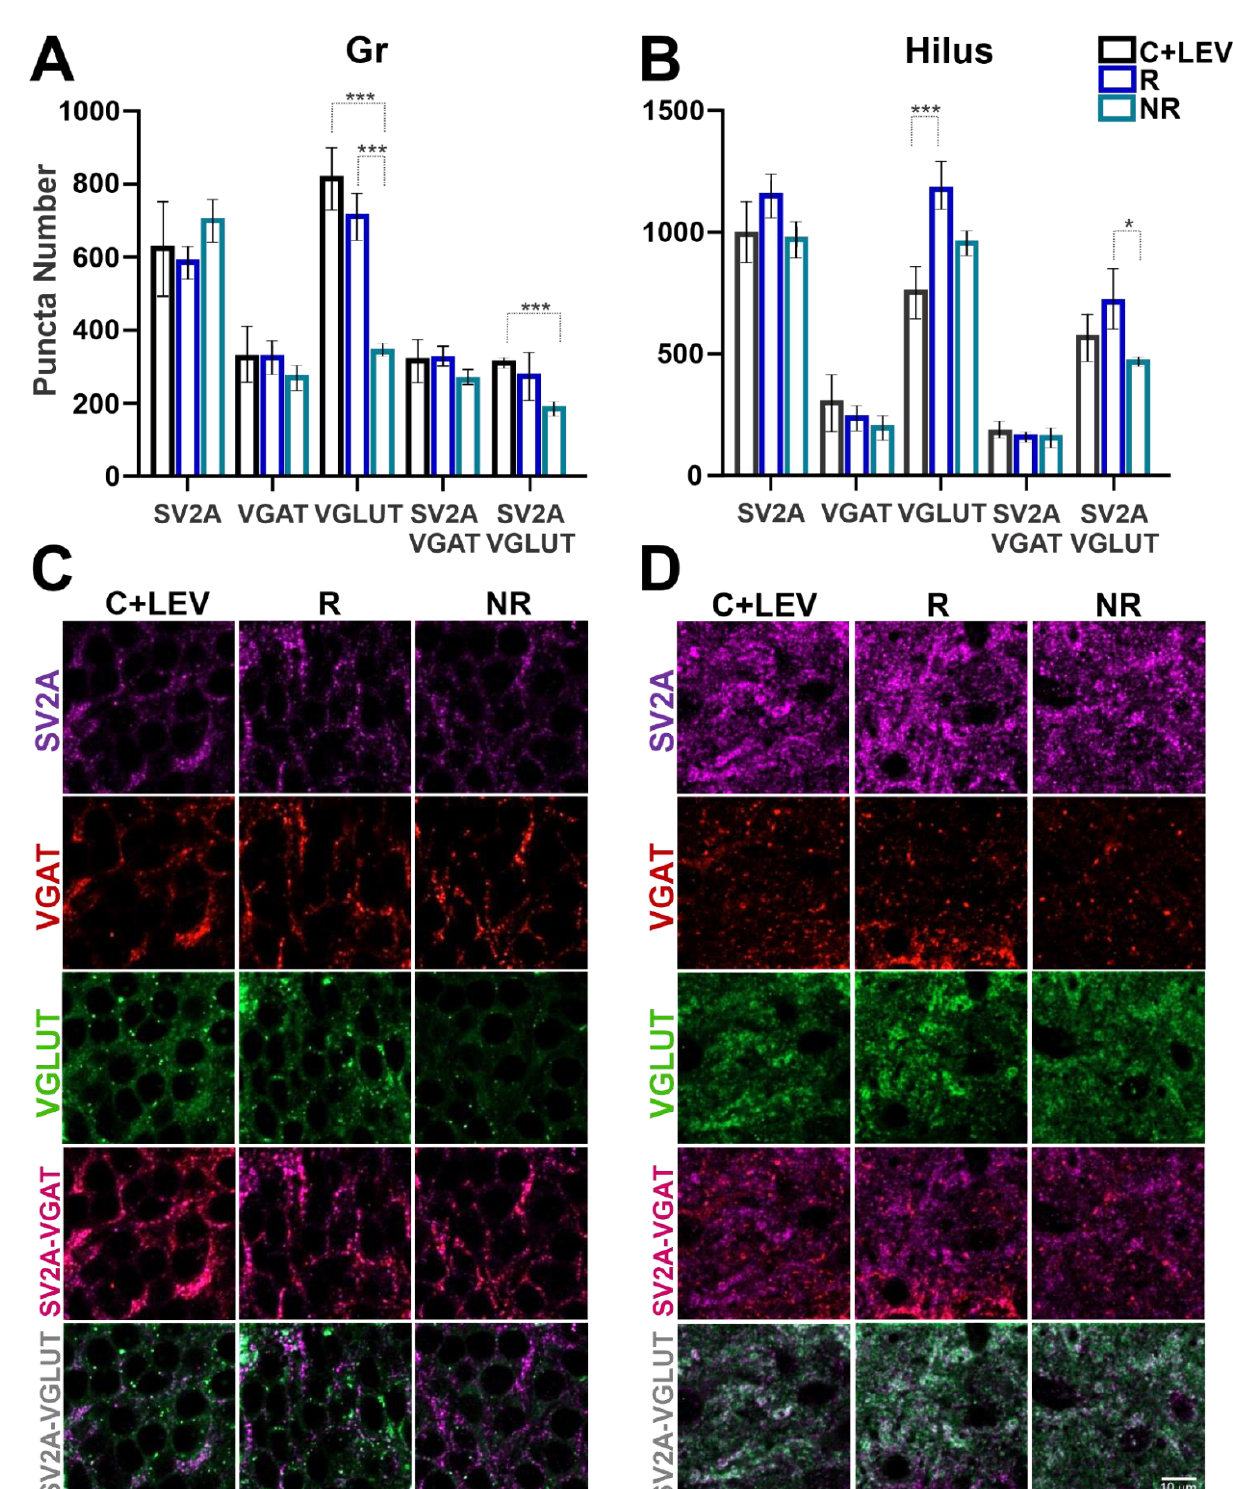
Figure 4. Quantification of SV2A, VGAT, VGLUT, SV2A-VGAT or SV2A-VGLUT puncta in the dentate gyrus granular layer (Gr) and hilus. ( A , B ) Graphs showing protein puncta (mean ± SD) in confocal images (50 × 50 µm) and their co-localization in C+LEV, R and NR animals. * p ≤ 0.05, *** p ≤ 0.001 ( C , D ) Confocal images of immunofluorescent SV2A (purple), VGAT (red) and VGLUT (green) puncta in the Gr and hilus, as well as SV2A-VGAT (magenta) or SV2A-VGLUT (gray) co-localized puncta in control plus levetiracetam (C+LEV), responder (R) and non-responder (NR) rats.